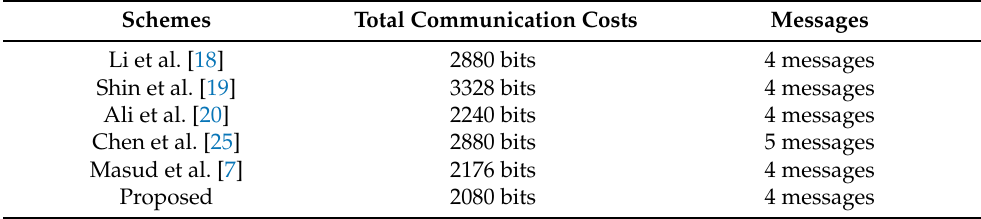
Table 4. Comparison of communication